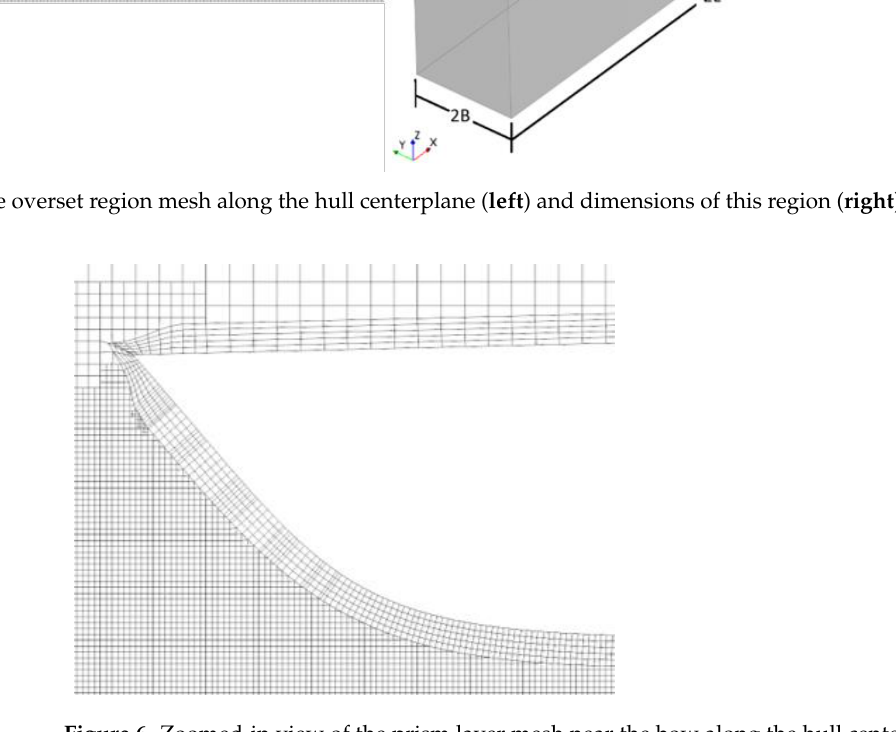
Figure 6. Zoomed-in view of the prism layer mesh near the bow along the hull centerline.